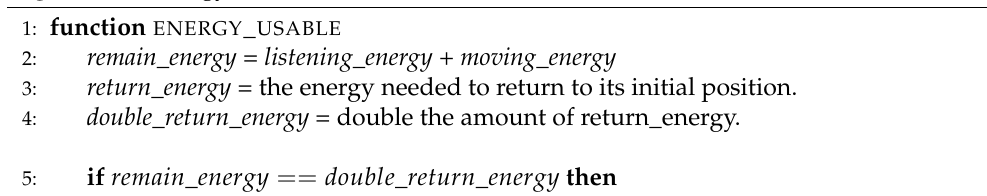
Algorithm 4 Energy Usable Function for mobile node m